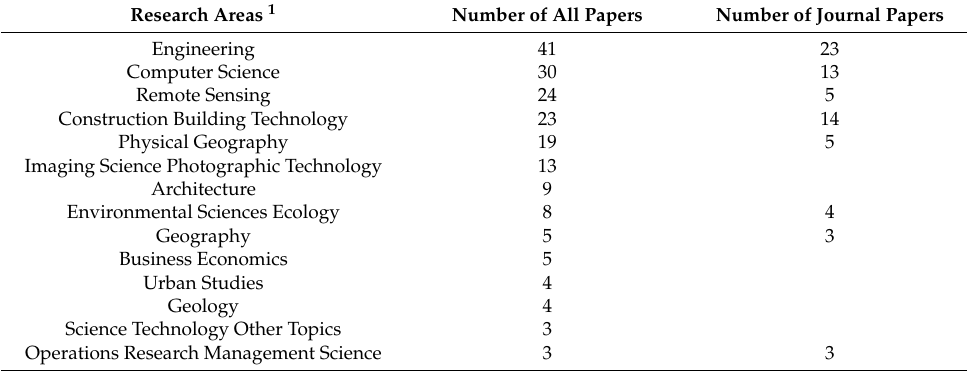
Table 1. Summary of research areas for the publications of building information modelling and geographical information system (BIM-GIS)